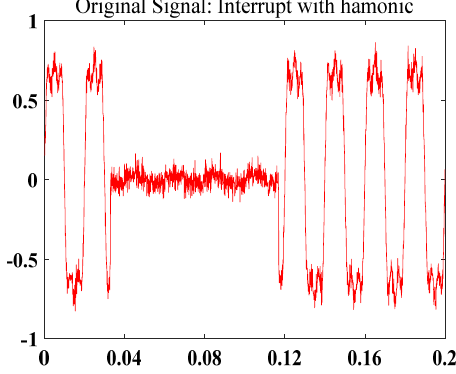
Figure 6. Original signal of interruption with harmonics.